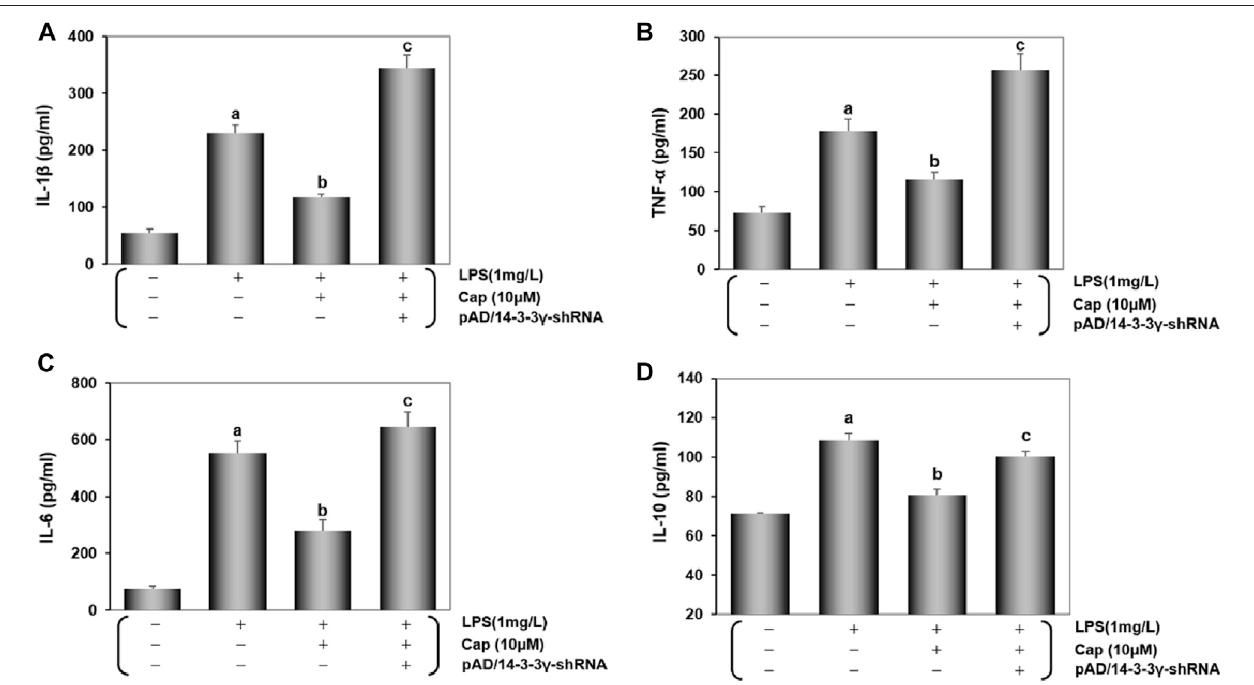
FIGURE 4 | Cap inhibits the activation of in fl ammatory cytokines in LPS- challenged cardiomyocytes. (A-D) IL-1 β , TNF- α , IL-6, and IL-10 were measured in the culture supernatant of cardiomyocytes by diversiform ELISA assays. Values are presented as mean ± SEM. For fi ve individual experiments, a: P < 0.01 vs. the control group; b: P < 0.01 vs. the LPS group; c: P < 0.01 vs. the Cap+LPS